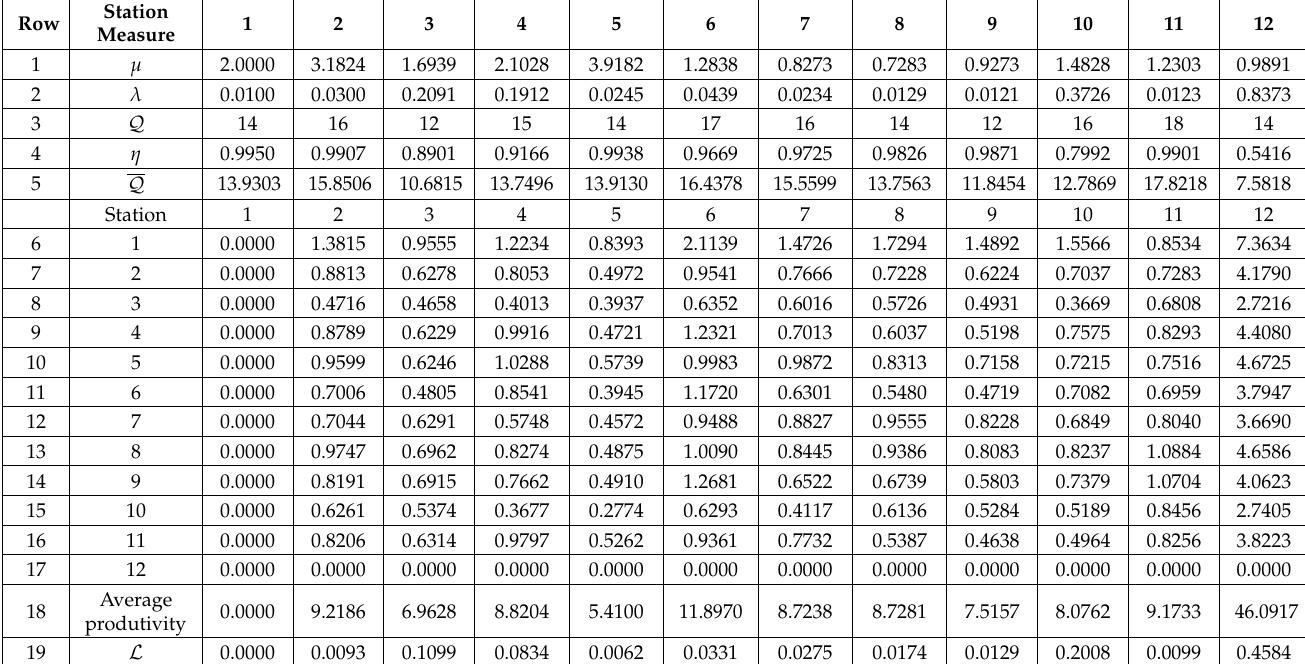
Table 7. Average production per workstation (states) pieces/unit of